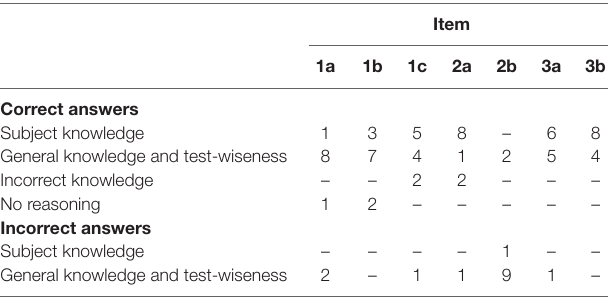
Table 4 | Students’ strategies in answering each multiple-choice-equivalent item.